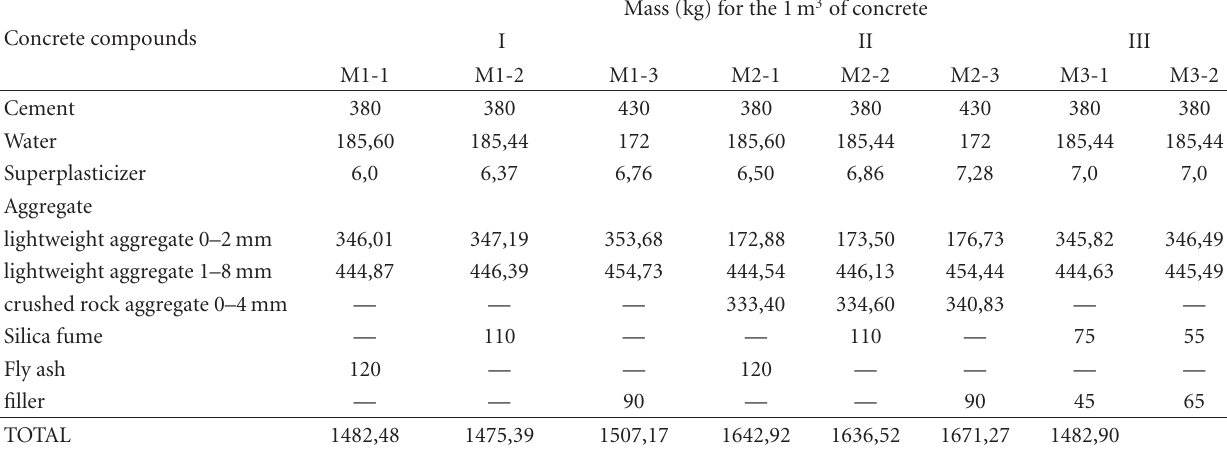
Table 2: Mixture designs.